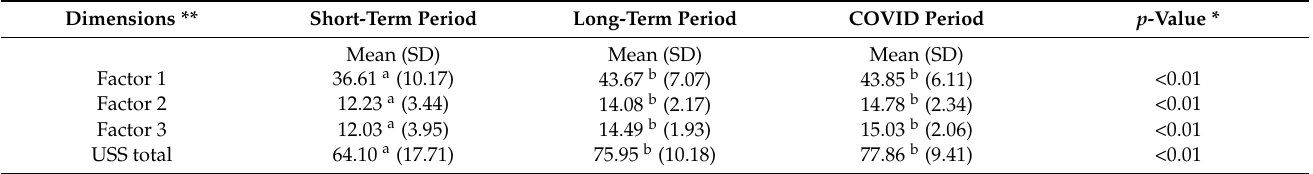
** Factor 1 represents to the psychic/cognitive dimension of USS. Factor 2 represents the physical and/or somatic dimension of USS. Factor 3 represents the social and behavioural dimension of USS. * p < 0.01. Different letters in the means represent statistically significant differences ( p ≤ 0.05) within the groups. USS—Unemployment Syndrome